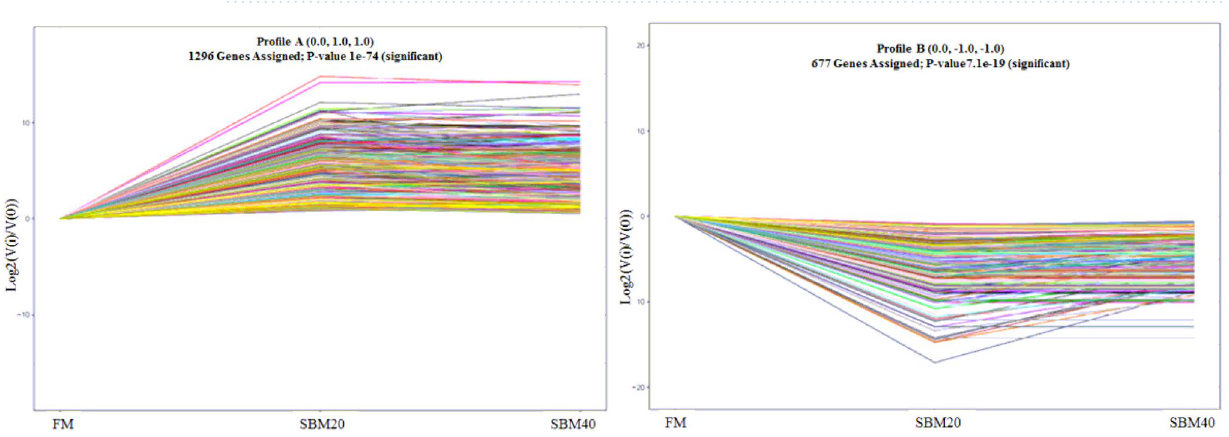
Figure 8. Cluster heat map of significantly DEGs in DI tissues of pearl gentian grouper fed by different substitution levels of SBM diet (n = 4).